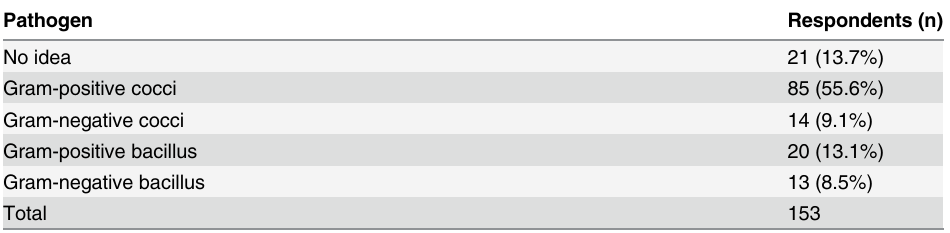
Table 5. The most common causative pathogen in post-traumatic endophthalmitis.